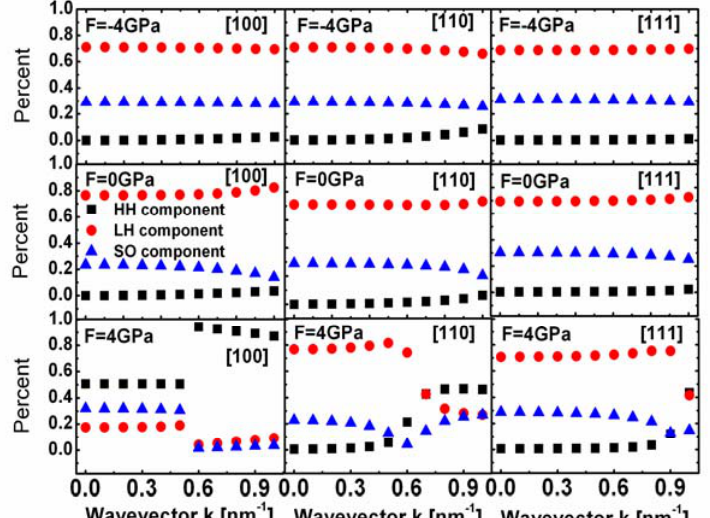
Figure 5. Percent of the HH, LH, SO components in the first subband of the simulated SiNWs versus wavevector k